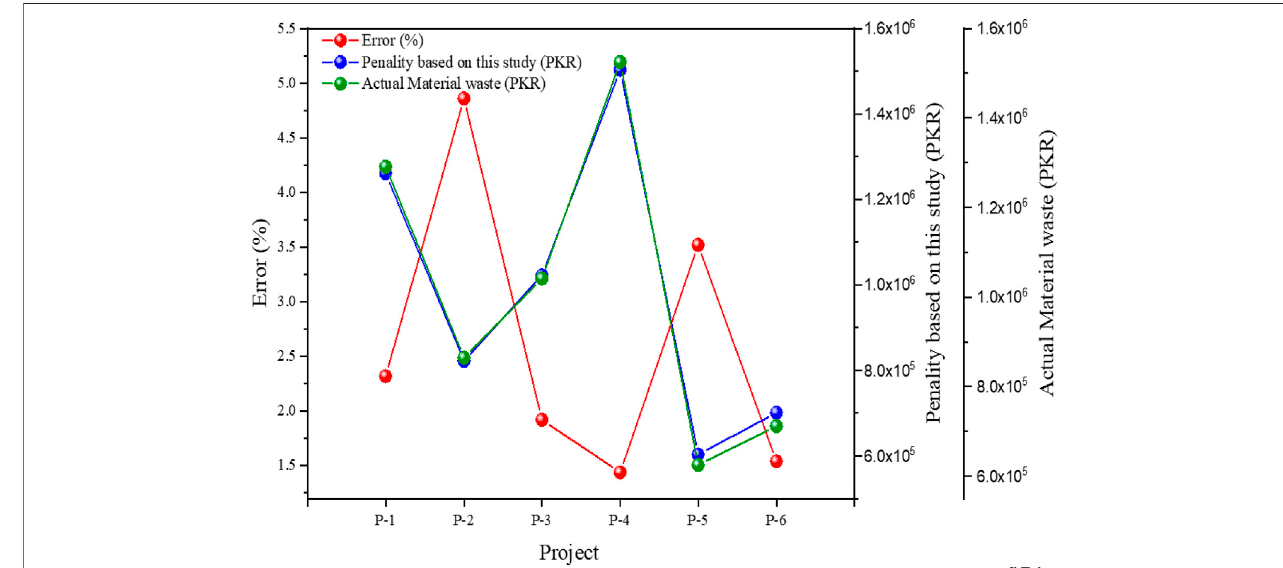
FIGURE 9 | Penalty error (%), actual material waste and calculated penalty